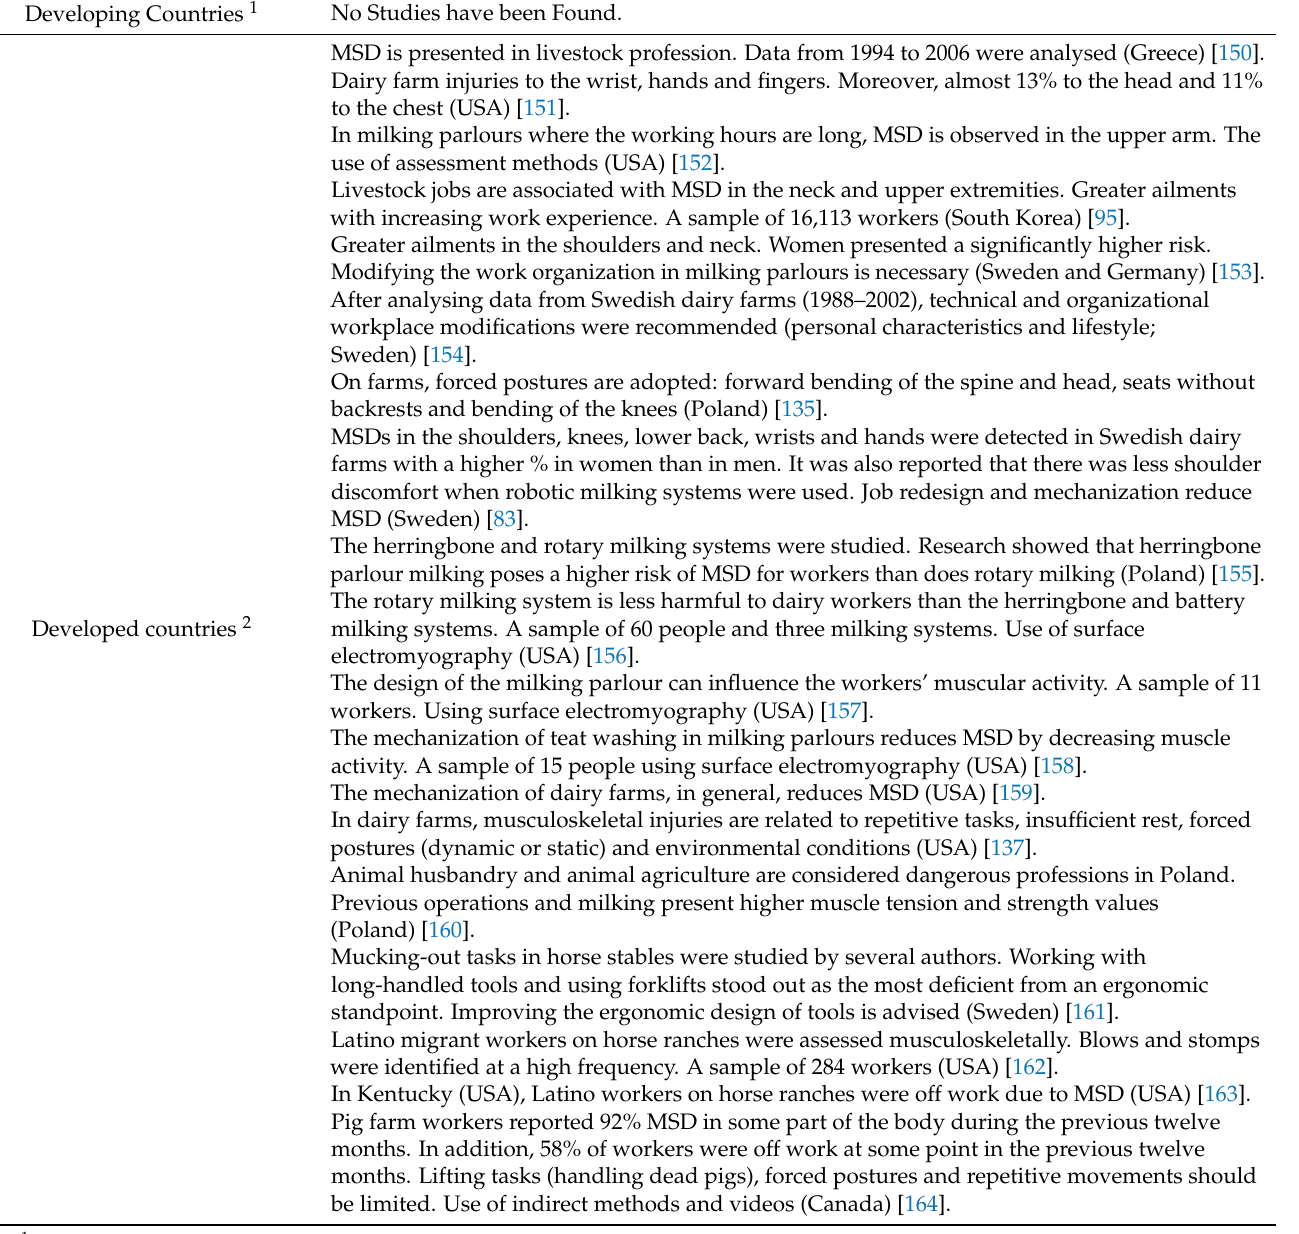
Table A9. MSD research in agriculture (1995–2020). Category: Livestock/Farms. Livestock/Farms Developing Countries